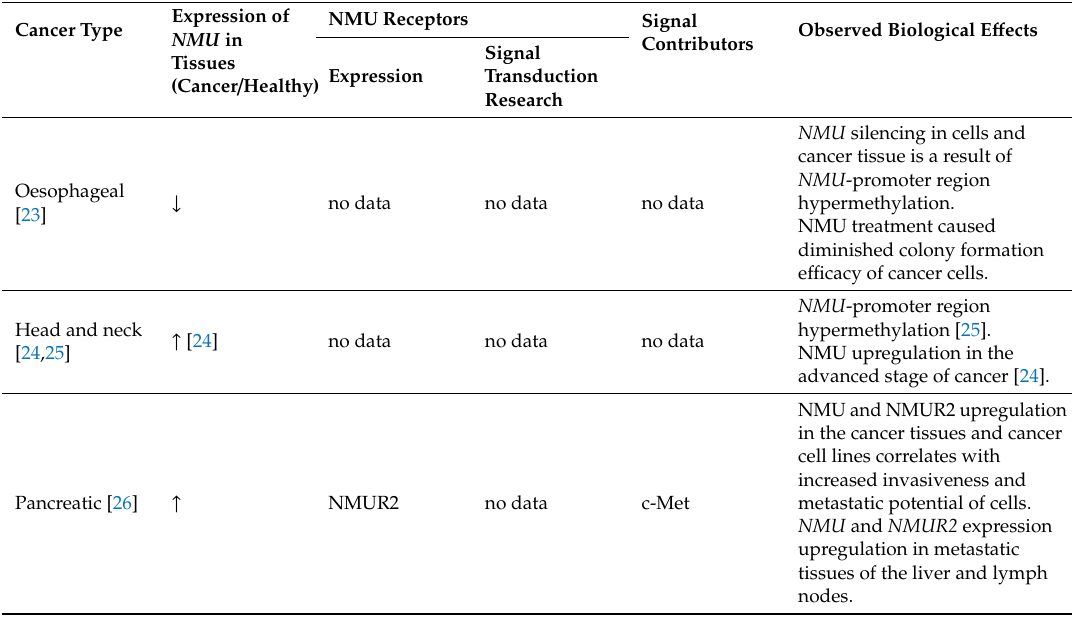
Table 1. Cell signalling related to NMU in various cancers. Grey charts present factors which influence NMU expression and white charts factors a ff ected by NMU expression in